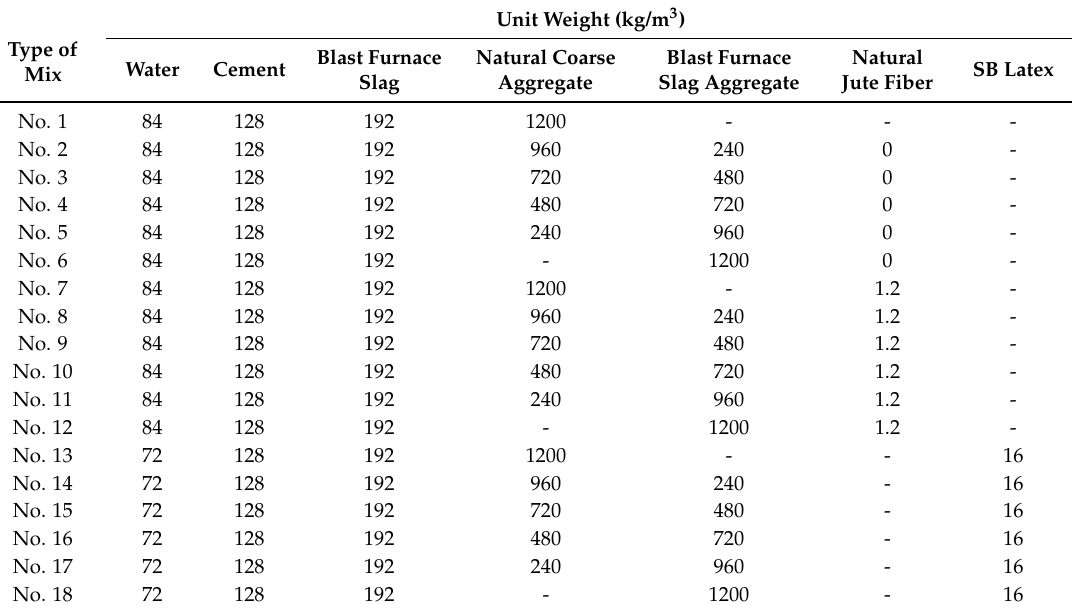
Table 6. Mix proportions of porous concrete for plant growth. SB = Styrene